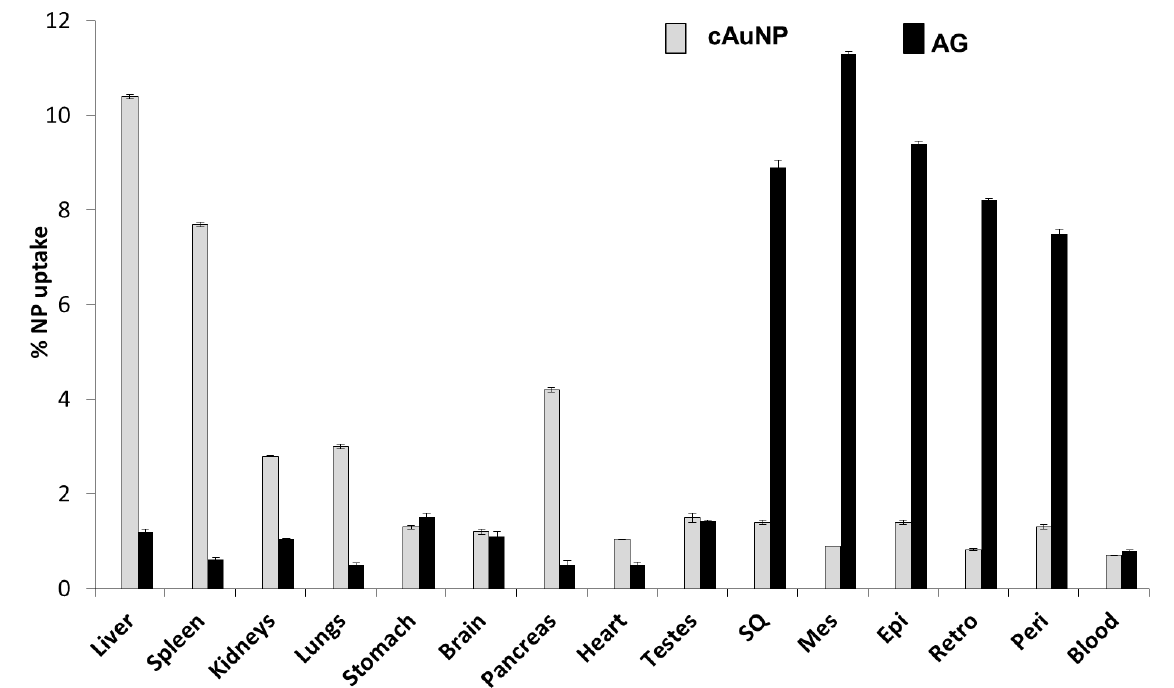
Figure 2. Biodistribution of AuNPs in obese Wistar rats. Reproduced with permission from Springer